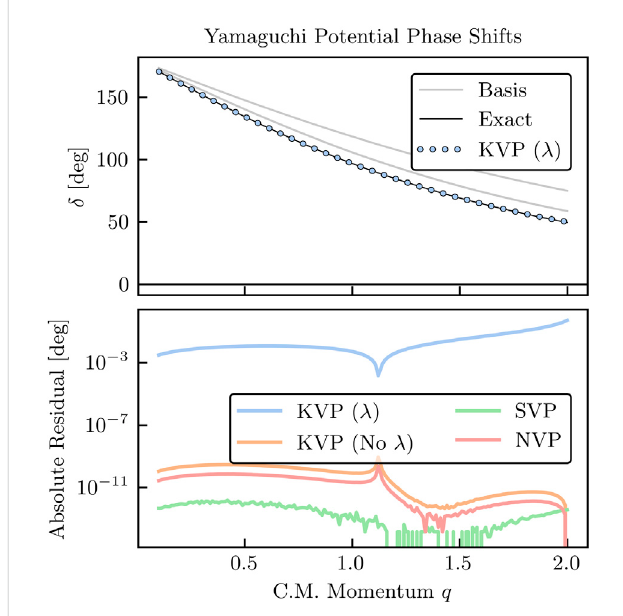
FIGURE 9 Phase shifts (top panel) and absolute residuals (bottom panel) in arbitrary units for the Yamaguchi potential Eq. 87 for each scattering emulator discussed above. The solid black lines represent the high- fi delity solution and the dots represent the emulator results. The emulators are so accurate that they are indistinguishable unless looking at residuals. The training set is given by the two gray lines.